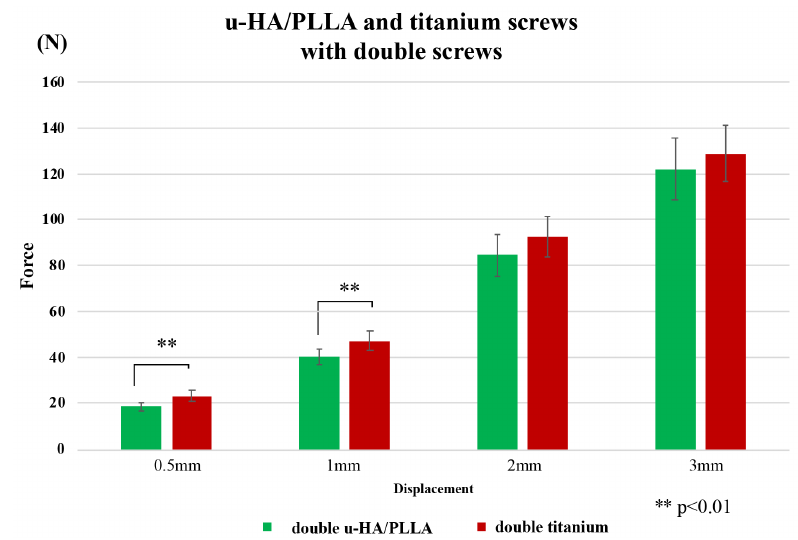
Figure 7. Comparison between titanium and u-HA/PLLA screws with double fixation in the horizontal test.